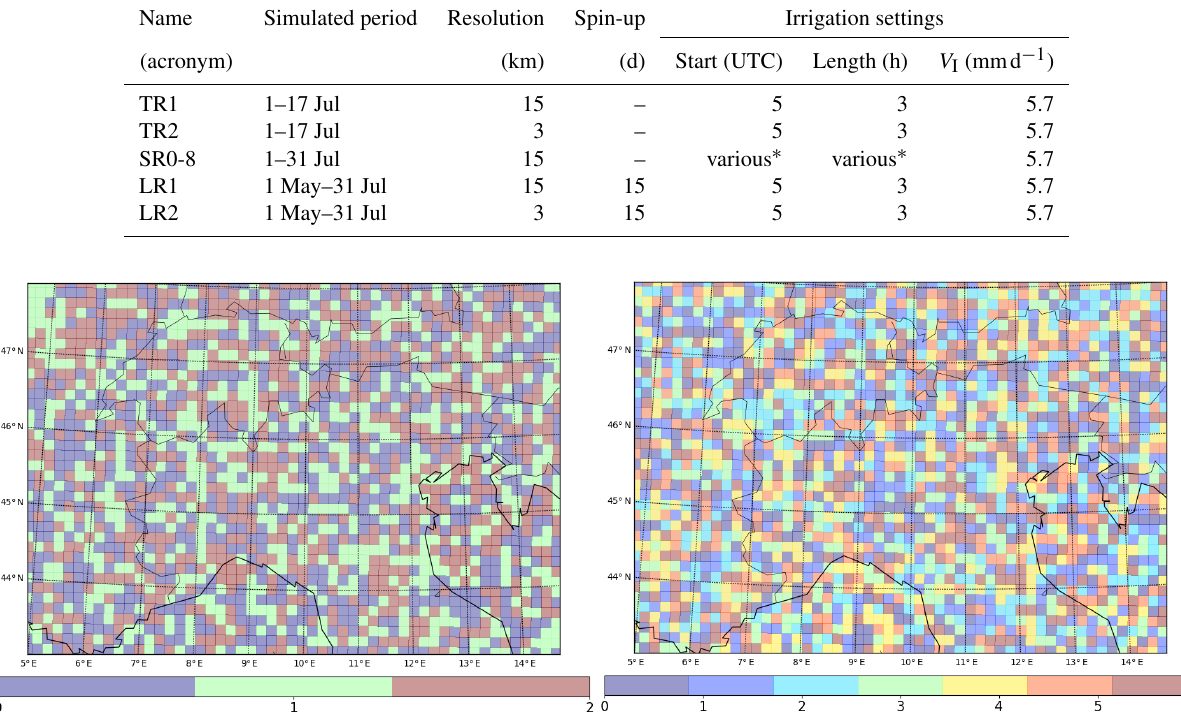
Figure 4. Activation field in days since the start of the sequence counting and highlight of the Po Valley region.